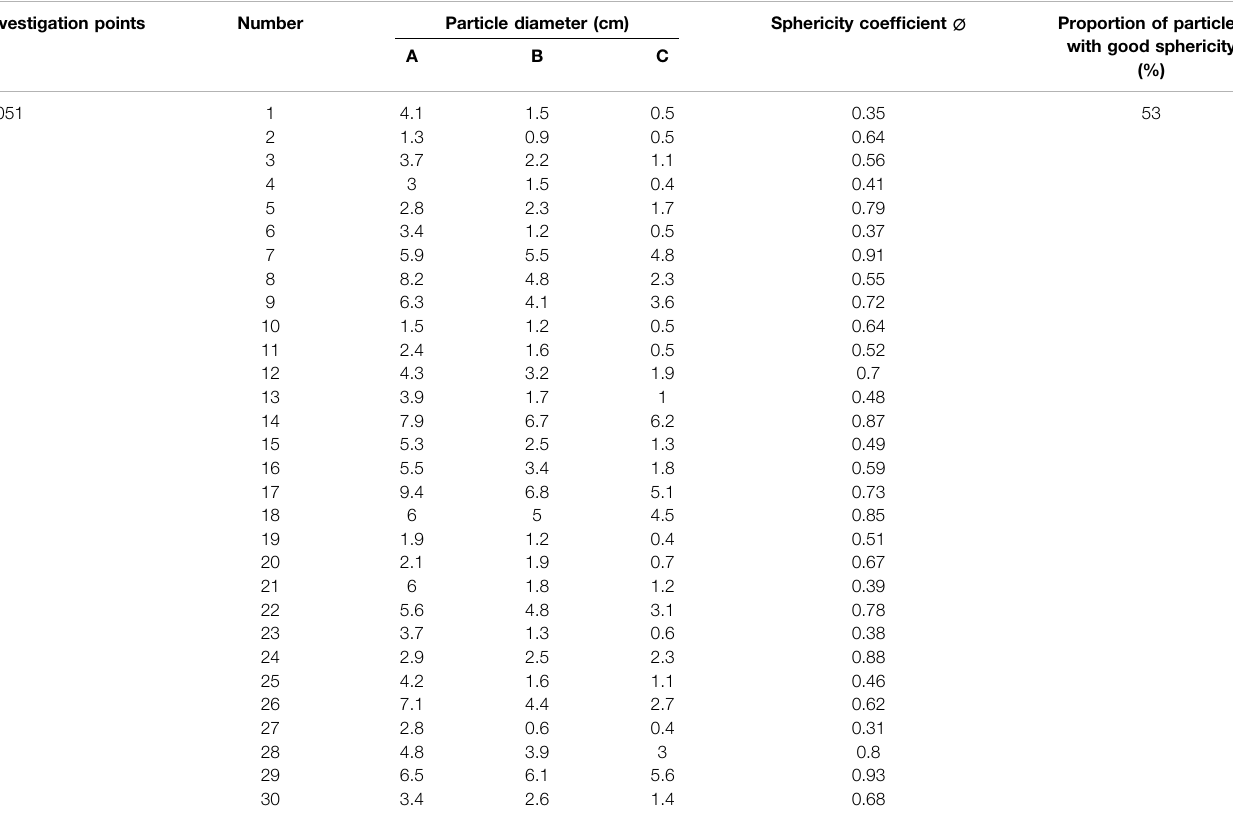
plane. The three axes A , B , and C are perpendicular to each other in space but do not necessarily intersect at one point ( Figure 15 ). The sphericity of debris particles was investigated at the Jiaopenba landslide accumulation area. The survey points were D032, D033, and D051 (the locations of the survey points are shown in Figures 2 , 7 , 9 , 10 ). At each survey site, a measurement area was randomly selected. According to the calculation formula of the Krubin sphericity coef fi cient, 30 debris particles were randomly selected in the measurement area to calculate their sphericity. Finally, the sphericity coef fi cients of each debris particle were statistically summarized ( Table 1 ). Results